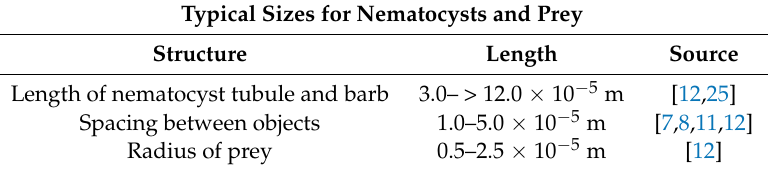
Figure 3. Diagram of the discretized structures. In the first stage of a simulation (I, left), the discretized barb (indicated by circles) is tethered to points (denoted by × ’s) moving with a specified velocity v in the positive vertical direction. The triangle indicates that the velocity increases linearly in time until a maximum value of 18 m/s as described in Section 2.4. In the next stage of the simulation (II, right), the barb is no longer physically linked to the moving points, and the barb’s motion is due solely to the interaction of the barb with the fluid. The velocity arrows u illustrate that the velocity of the barb (and fluid) decreases over time, although not necessarily linearly. The barb approaches the prey, which is initialized into a circular configuration. All structures are immersed in water. Table 1. Parameters taken from measurements for organisms. The prey radius can be much larger, for example in Hydra . Experimental values for the barb size in Hydra are difficult to obtain because the tube shaft is still attached to the barb during the ejection process and the ultrafast dynamics of firing. Note the length of the barb and tubule together can vary over several orders of magnitude, for details on the diversity of structures and prey sizes, see the references noted in the table. We consider a typical structure size on the order of the distance between the structures to focus on the contact event.